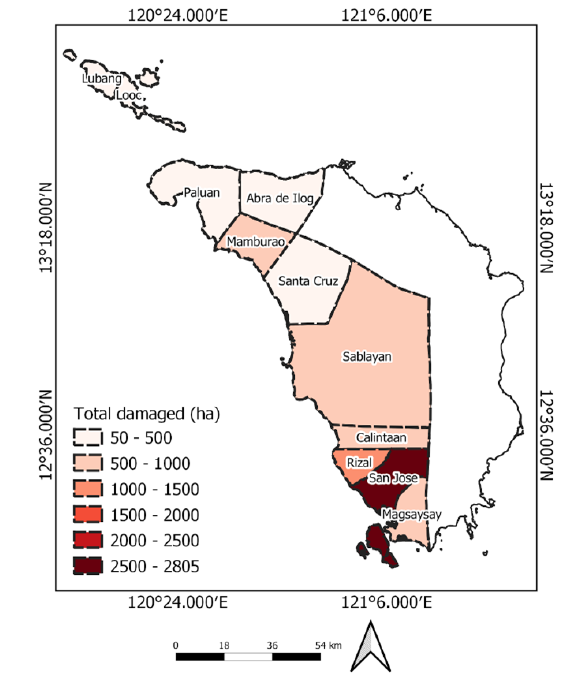
Figure 8. Crop damaged reports (rice and corn) expressed in total hectares damaged in Occidental Mindoro within the January to April 2019 cropping